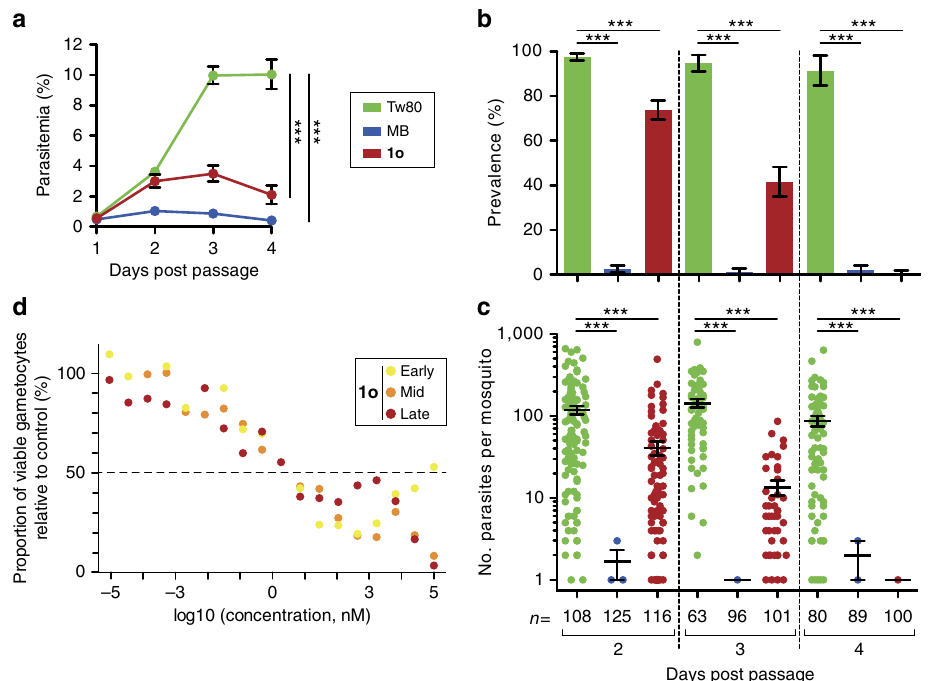
Figure 3 | Effect of compound 1o on P. berghei multiplication in mice and on parasite transmission to mosquitoes. ( a ) Naive mice were injected i.v. with infected blood and treated daily for 3 days starting 24h post passage with compound 1o (100mgkg (cid:3) 1 ), with methylene blue (MB, 15mg/kg), or with vehicle (Tw80) as positive and negative controls, respectively. Parasitemia was monitored daily and the mean ± s.d. of three independent experiments are plotted. Groups of mosquitoes were fed on mice 24h after each treatment. ( b ) Prevalence (percentage of infected mosquitoes) and ( c ) infection intensity (mean number of parasites per infected midgut) were determined 7 days post infectious blood feeding. The results of four independent experiments were pooled, and the mean ± s.e. of the mean is shown ( b , c ). Significance for differences between treatments was calculated using generalized linear models with treatment, time, and repeats as variables, *** P value o 0.001 ( a – c ). n , number of mosquitoes. ( d ) Effects of compound 1o on early, mid, and late stage P. falciparum gametocytes. Representative data sets are given (4.5% gametocytaemia) out of three independent experiments. Survival of treated gametocytes was calculated for each concentration relative to parasites exposed to